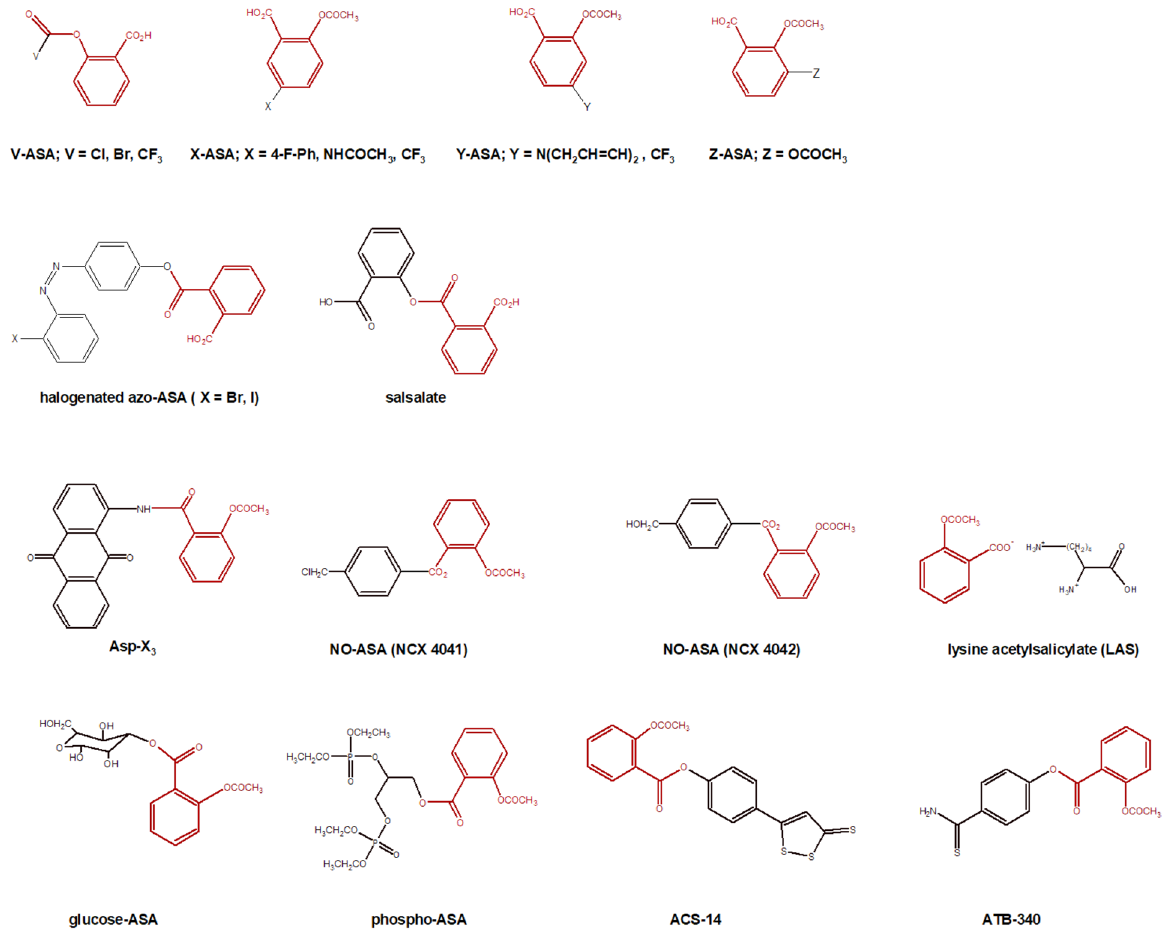
Figure 7. Chemical structures of other ASA derivatives. ASA moiety is marked in red.